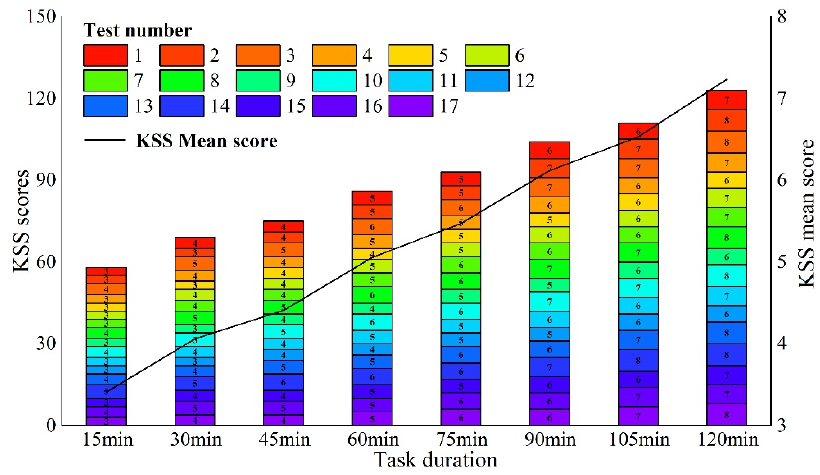
Figure 17. Mean values of response time and accuracy of subjects at different time periods for the CPT task.